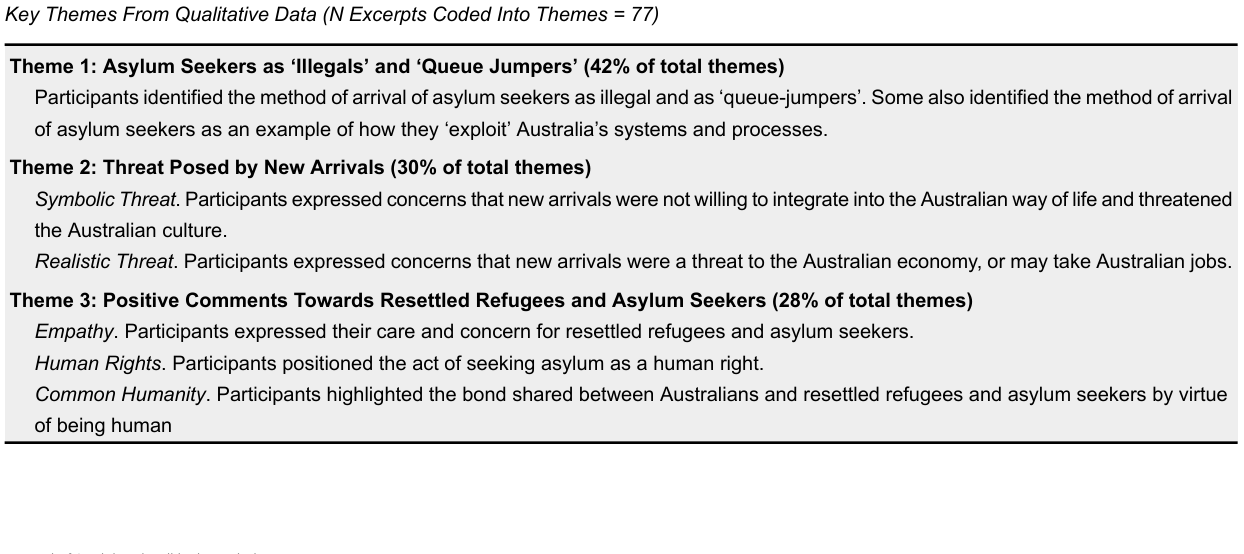
Key Themes From Qualitative Data (N Excerpts Coded Into Themes =